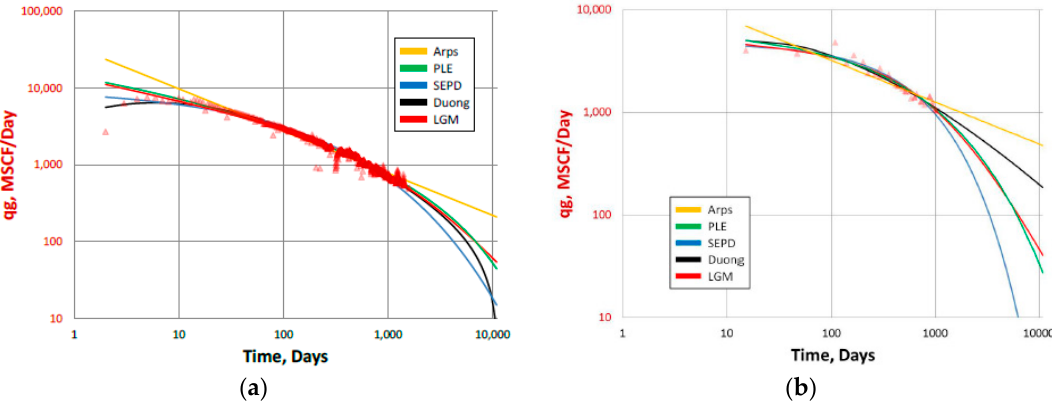
Figure 4. Comparisons of four DCA models [12]: ( a ) Barnett shale gas well 314 results comparison; ( b ) Eagle Ford shale gas Well 204 comparison.